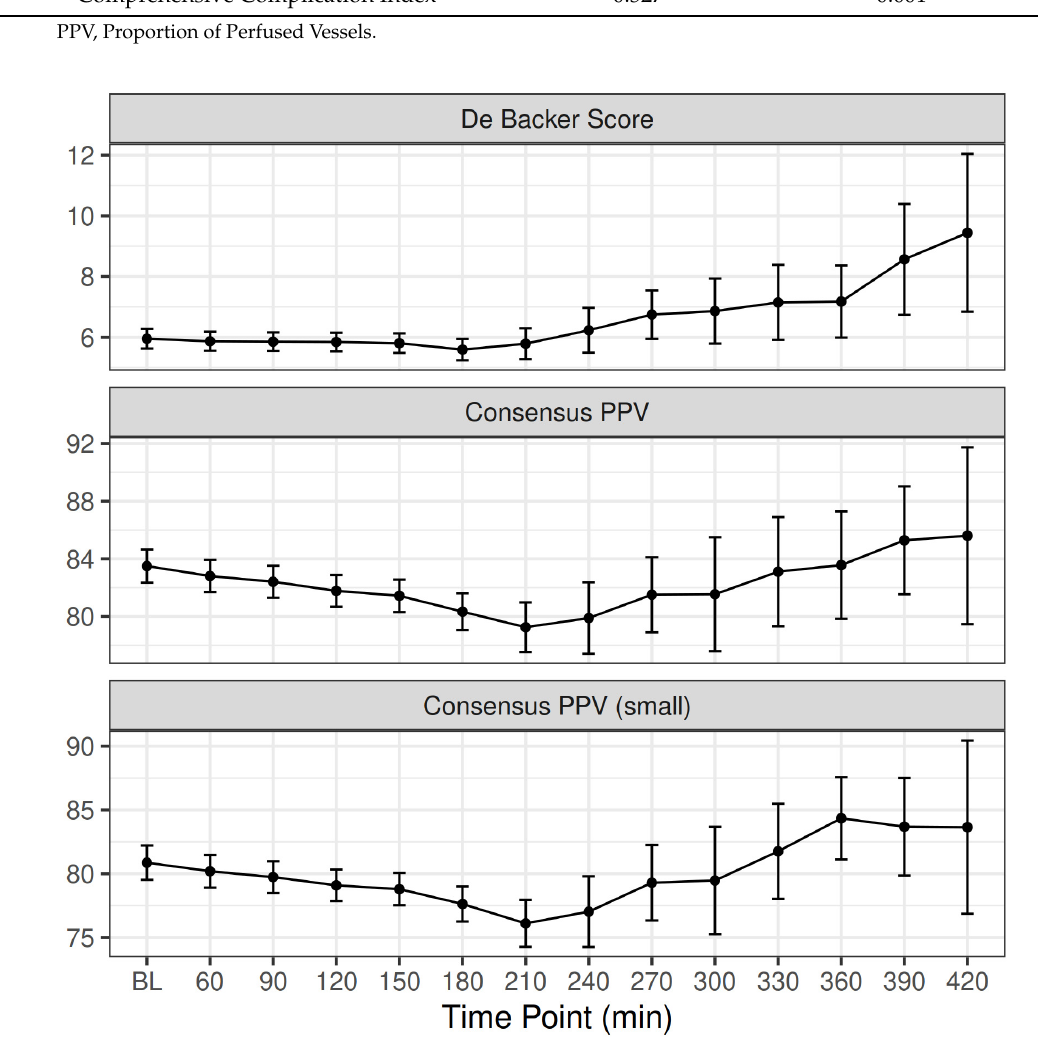
Figure 2. Intraoperative change in De Backer score (mm − 1 ), Consensus PPV (%), and Consensus PPV (small) (%) with time. BL, baseline measurement (30 min). Number of patients at each time point: 30–120 min: 100 patients; 150 min: 96 patients; 180 min: 72 patients; 210 min: 49 patients; 240 min; 27 patients; 270 min: 22 patients; 300 min: 12 patients; 330 min: 8 patients; 360 min: 8 patients: 390 min: 4 patients; 420 min: 3 patients.